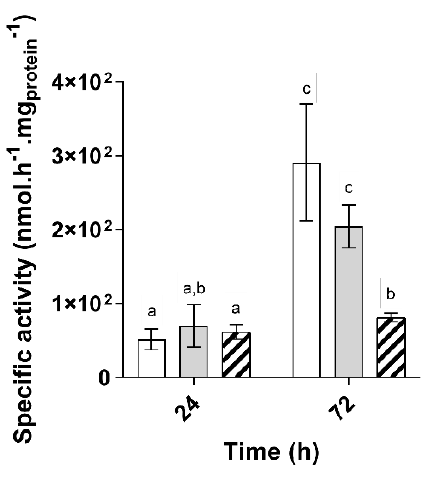
Figure 4. Differential expression of the enzymatic activity of Rs. rubrum acetolactate synthase in culture using propionate ( ■ ), butyrate (□), or a mixture of VFA S in culture supplemented with 50 mM of bicarbonate ( ) (n = 5).